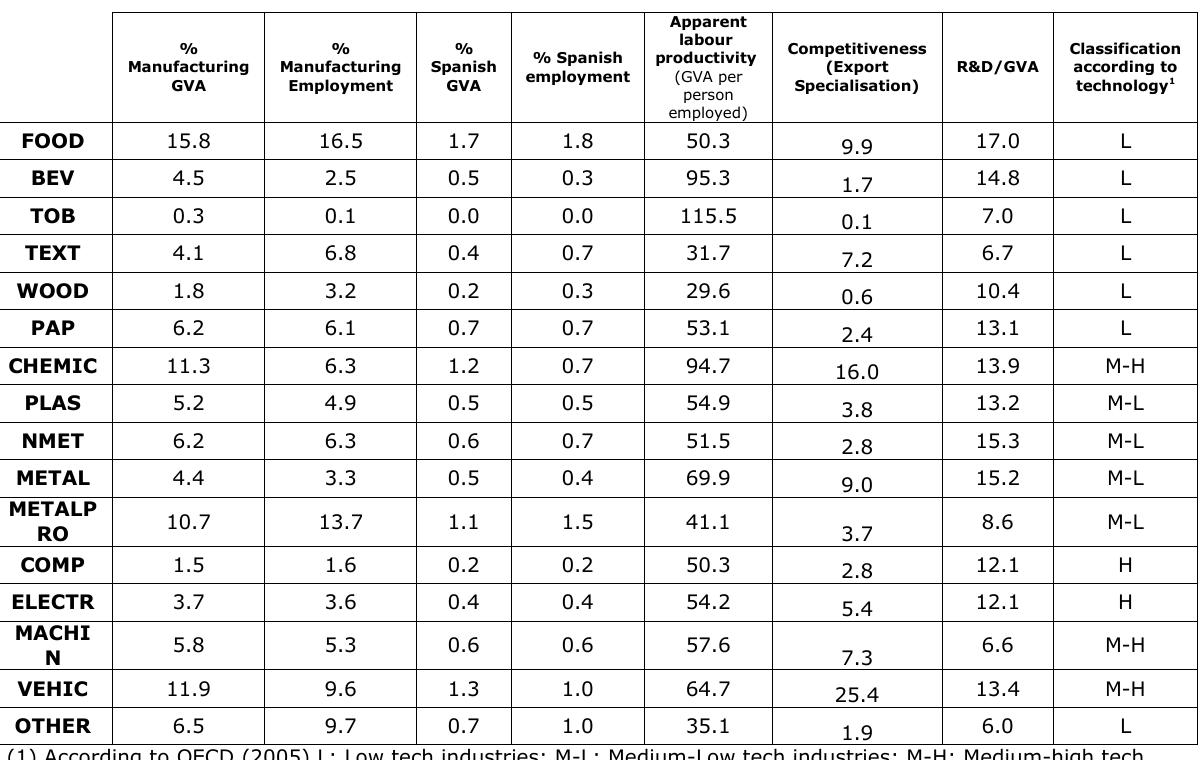
Table B.3. Main specific features of industries